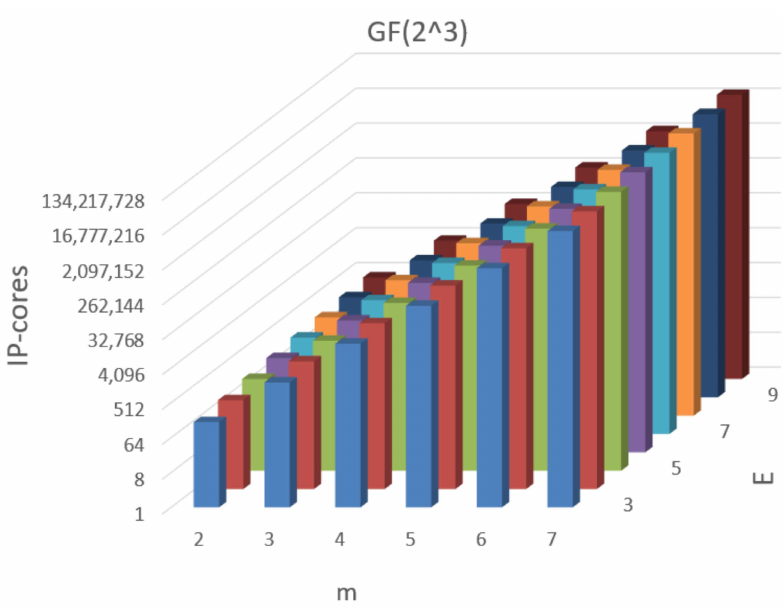
Figure 2. Total number of IP-cores for a group of polynomials over GF ( 2 3 )